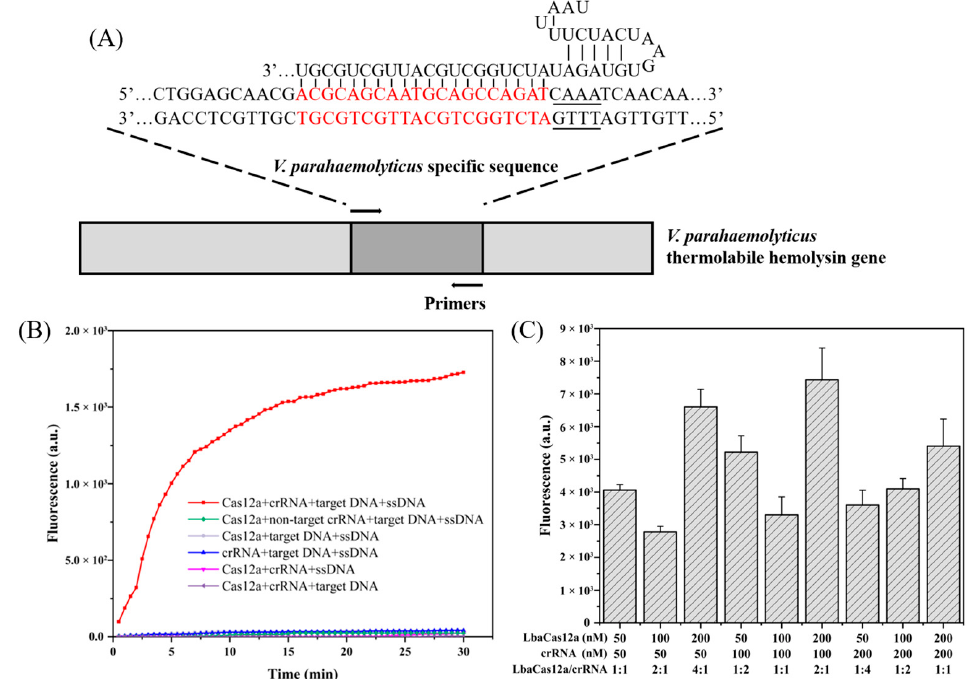
Figure 3. Feasibility analysis of RAA–CRISPR for nucleic acid detection. ( A ) Sequences of crRNA designs used for V. parahaemolyticus detection. ( B ) Feasibility of RAA–CRISPR for V. parahaemolyticus detection in fluorescence reporting. ( C ) Optimization of the Cas12a/crRNA concentration.